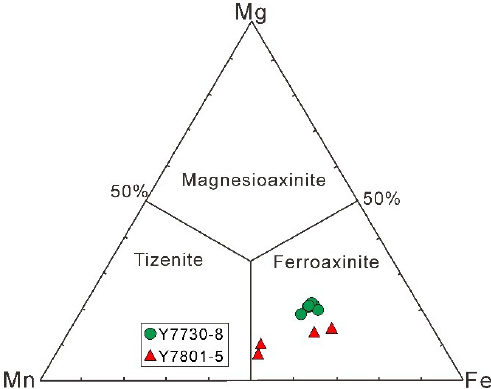
Figure 12. Chemical compositions discrimination of axinite in the Yamansu deposit (modified from [34]).